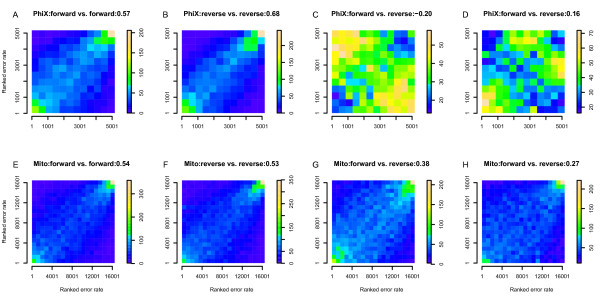
Sequencing error rate correlation between different subsets of the data. Sequencing errors are ranked from lowest to highest along each axis. The color in each bin represents the number of positions having the corresponding error rates in the two subsets. (a-d) Phix174 data. (e-h) mtDNA data. Correlation coefficients are shown at the end of the title of each plot.